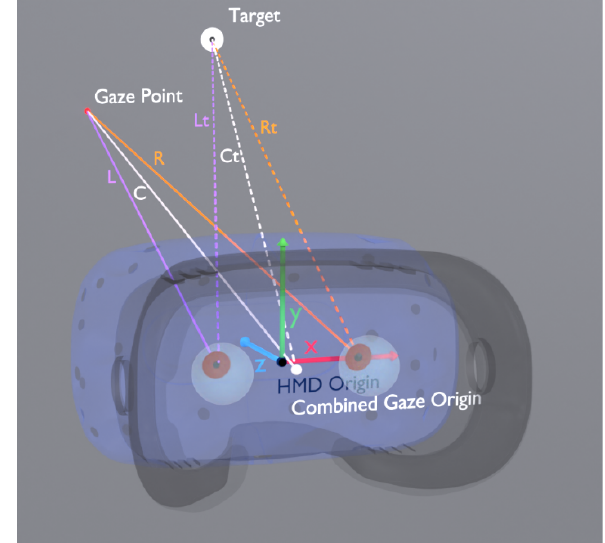
Figure 1. Depiction of the HMD with eye tracker coordinate system and relevant vectors. Small arrows represent the eye tracker’s coordinate frame, with its origin centered between the HMD’s lenses and x (red) towards the right eye, y (green)